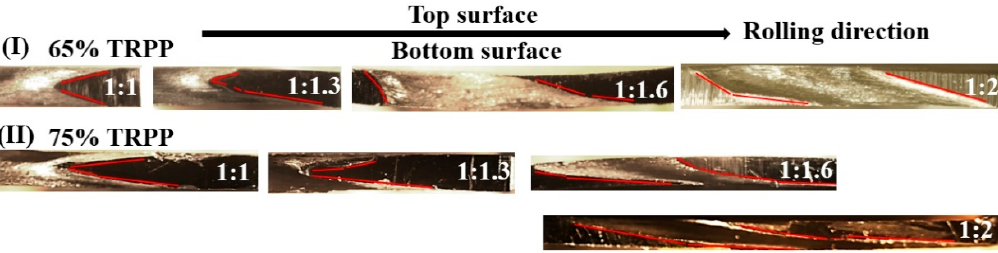
Figure 5. Changes in the geometry of the inserted pins and indentation marks with increasing roll diameter ratio at the same TRPP value (50%).